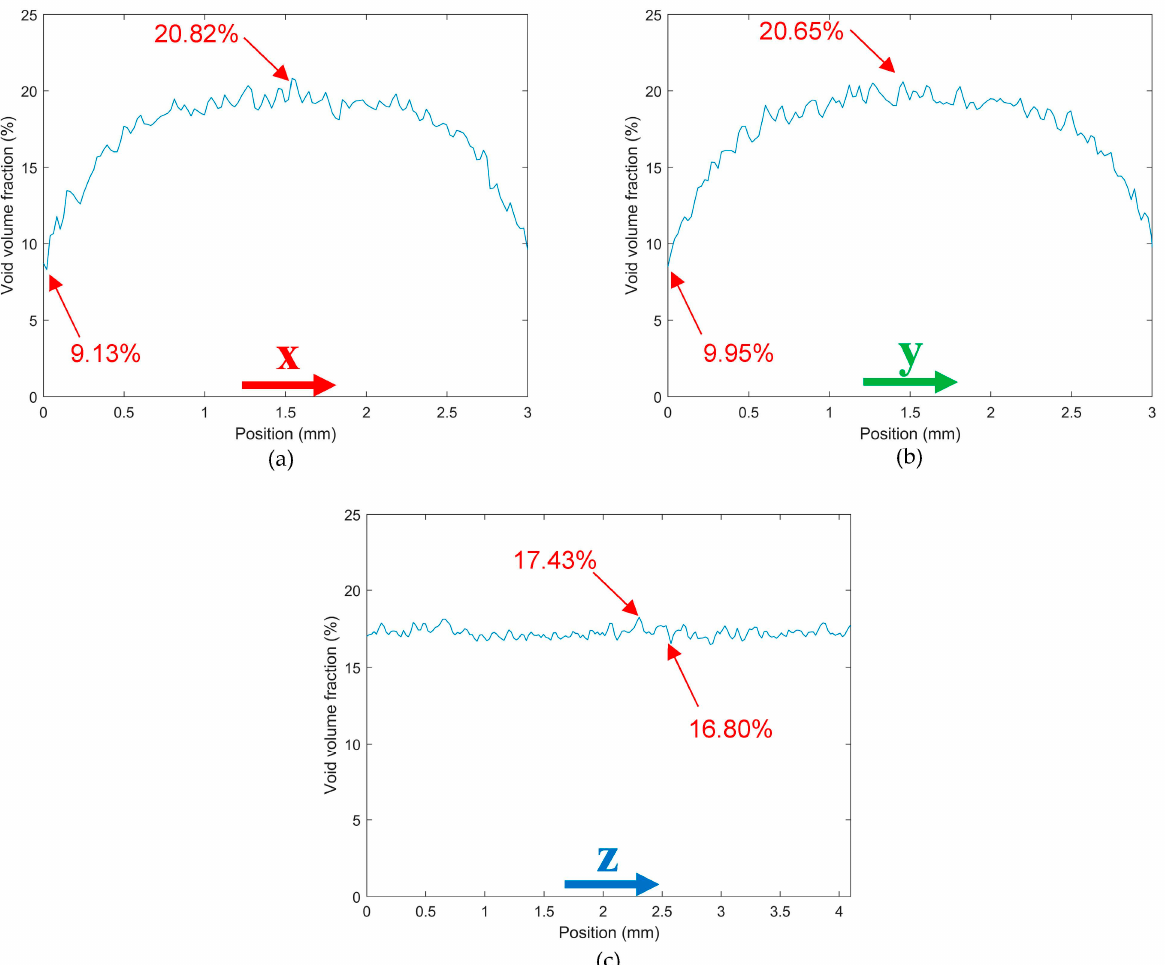
Figure 5. Void volume fraction along the coordinate directions of a SCF/ABS single freely extruded strand: ( a ) along the X-direction; ( b ) along the Y-direction; ( c ) along the Z-direction.